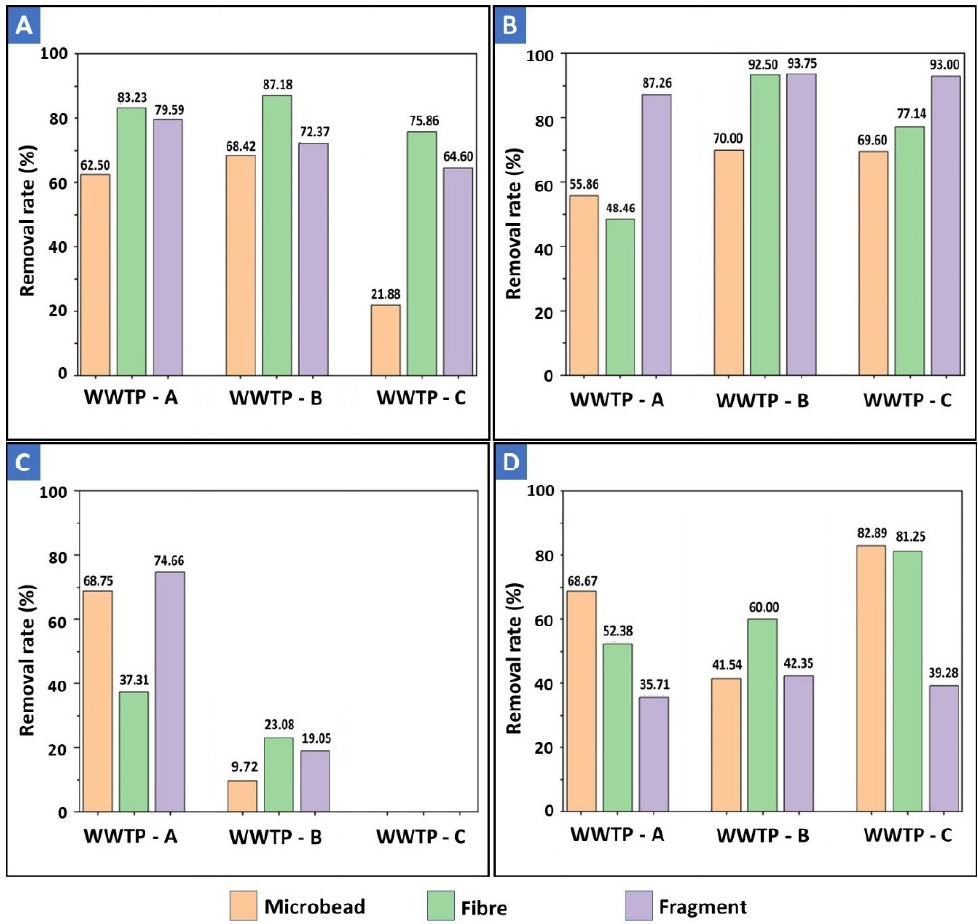
Figure 5. Removal efficiency of microplastic shapes at each treatment process. ( A ) Microplastic removal rate of screening and primary clarifier; ( B ) Microplastic removal rate of bioreactor and secondary clarifier; ( C ) Microplastic removal rate of coagulation; ( D ) Microplastic removal rate of disc-filter.